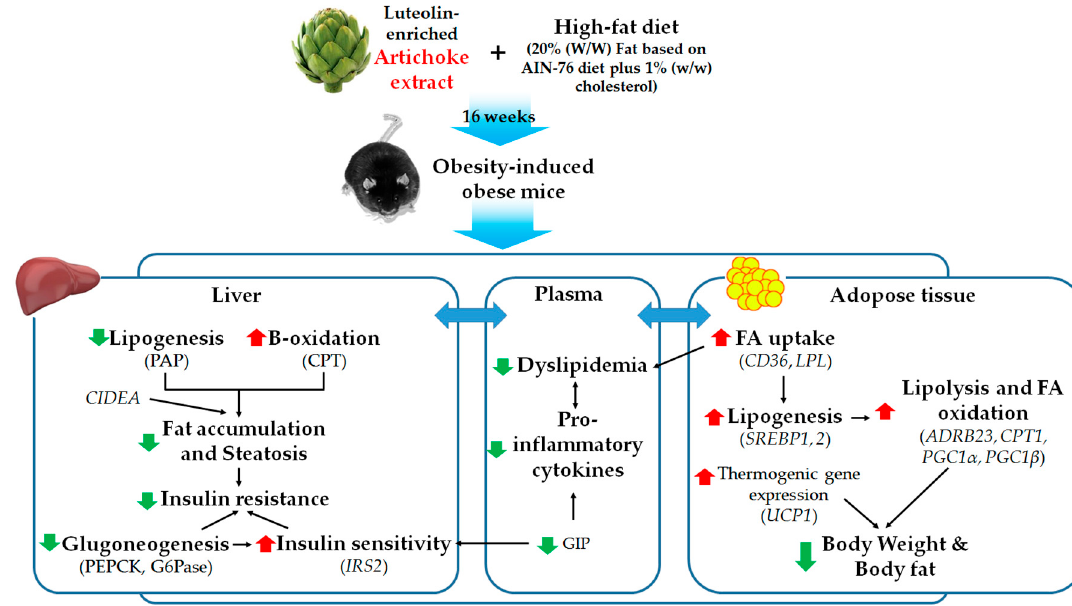
Figure 4. Proposed mechanisms for the anti-obesity effects of luteolin-enriched artichoke leaf (AR) extract. AR reduces adiposity by increasing adipocyte genes involved in lipolysis and FA oxidation as well as thermogenesis. In addition, AR not only activates FA uptake and lipogenesis in adipose tissue to prevent ectopic lipids in liver but also simultaneously increases FA oxidation, which may contribute to reduced adiposity, with improved dyslipidemia. AR also alters hepatic lipid and glucose metabolizing factors, which prevents hepatic steatosis by reducing the hepatic lipid load and eventually improving insulin resistance. This is associated with a decrease in the plasma pro-inflammatory cytokine levels.